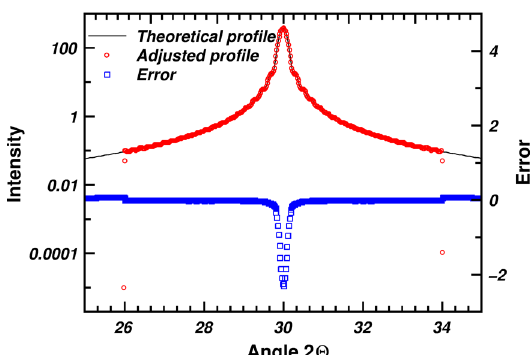
Figure 4. Theoretical diffraction pattern for a crystallite powder with spherical particles with 30 nm diameter and 0.154 nm radiation, the fitted convoluted pattern and difference curves